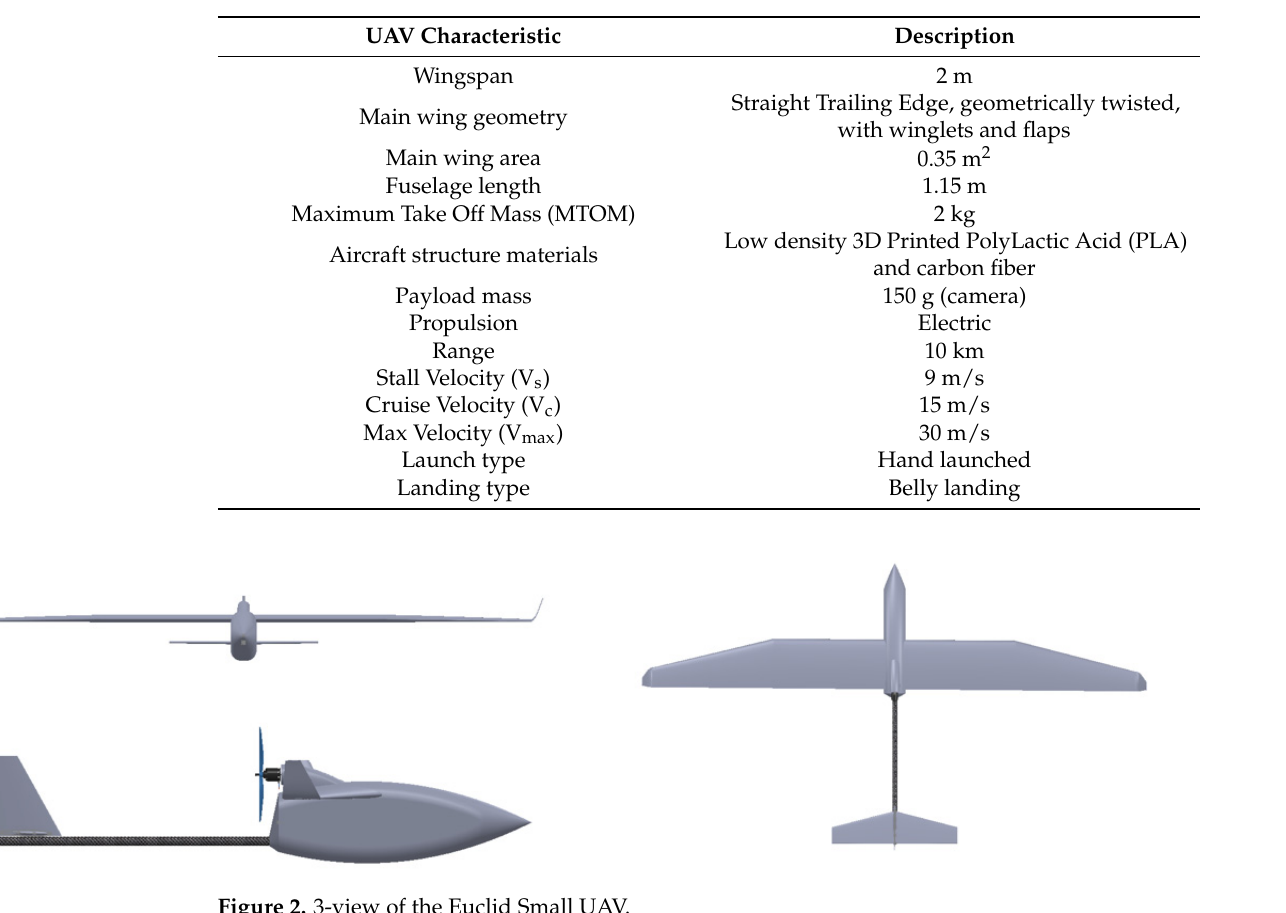
Table 1. Euclid SUAV characteristics.